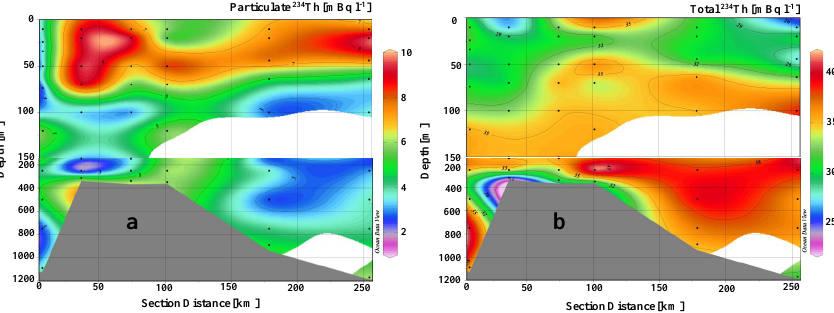
Fig. 5. Sectional distributions of 234 Th activity along a meridional transect (Transect M) across the Chatham Rise (see Fig. 1 for transect location): (a) particulate 234 Th and (b) total 234 Th.